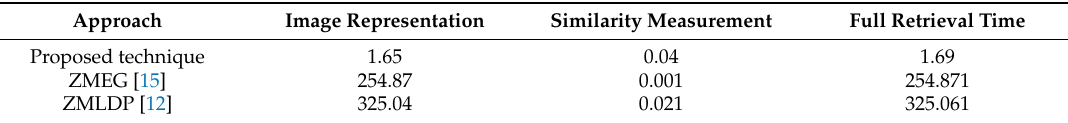
Table 2. Comparison of computation times in the retrieval process (Unit: ms).